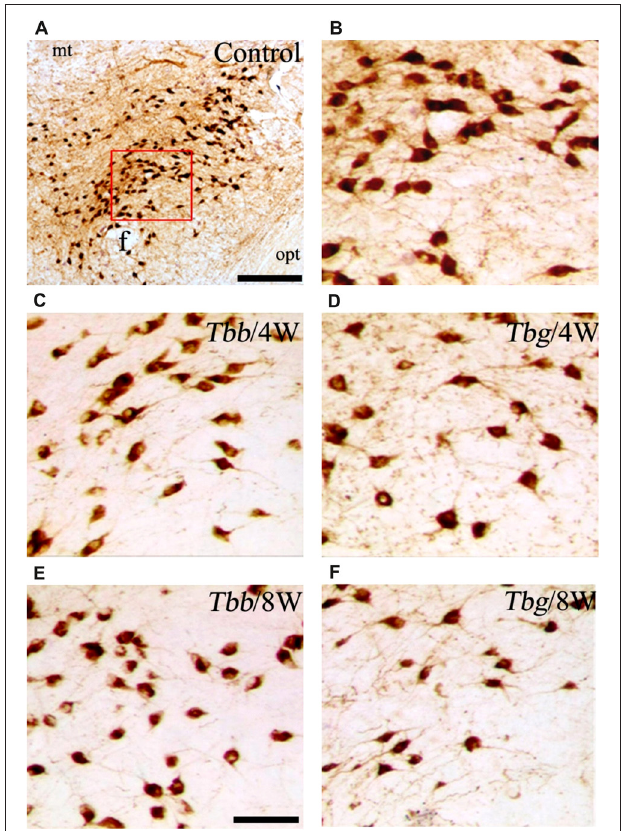
FIGURE 3 | (A,B) Images of orexin-A-immunoreactive neurons in uninfected Mastomys natalensis ( B represents at higher power the area boxed in A ), and at 4 weeks (W) and 8 W after infection with Trypanosoma brucei brucei ( Tbb ) or Trypanosoma brucei gambiense ( Tbg ) (C–F) . Abbreviations: f, fornix; opt, optic tract. Scale bars: 250 µ m in (A) , 150 µ m in (E) (applies also to B–D,F